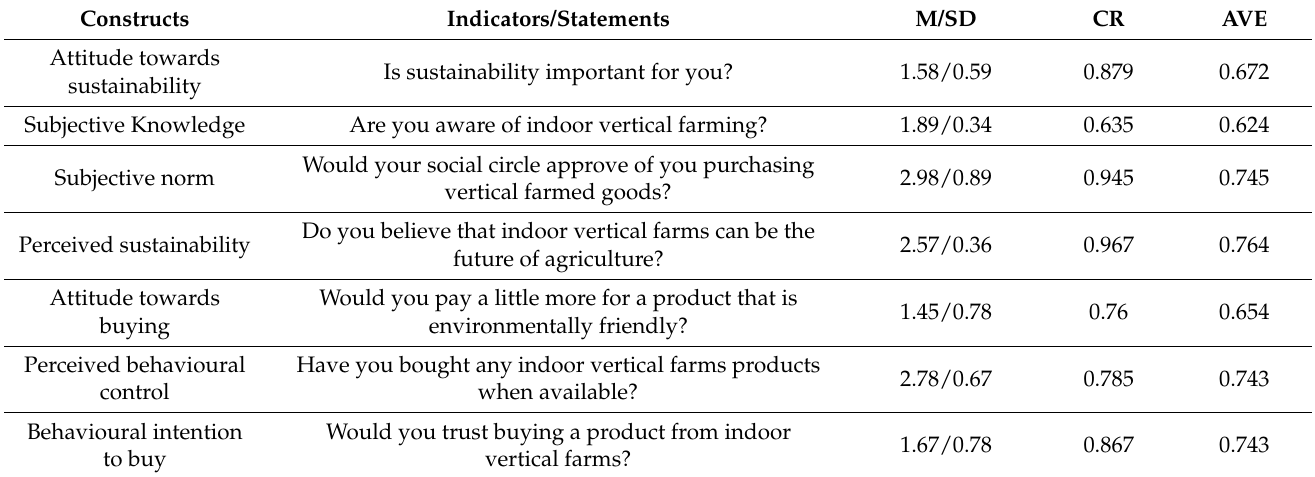
Table 2. Validity of the constructs of the extended technology acceptance model (where M is the mean value, and SD is the standard